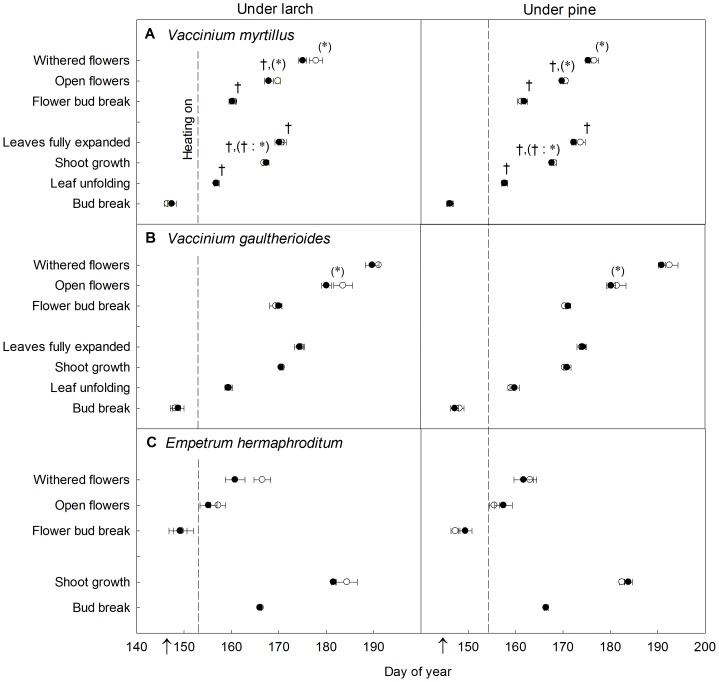
Vegetative and flowering phenology for the three dwarf shrub species studied. Circles represent the mean day of year (±1 SE) of each phenophase for the four different soil warming (open circles, unwarmed; closed circles, warmed) and plot tree species (larch or pine) combinations (n = 10). Crosses show significant differences between plot tree species (P<0.05) and marginally significant differences (0.05≤P<0.10) between soil warming treatments are given by asterisks in parentheses. Colons show treatment interactions. Note that in some cases symbols for different soil warming treatments overlap completely. Dotted lines show the date when the warming treatment started in 2012 and arrows on the x-axes show the mean snowmelt date for all plots with the same tree species.